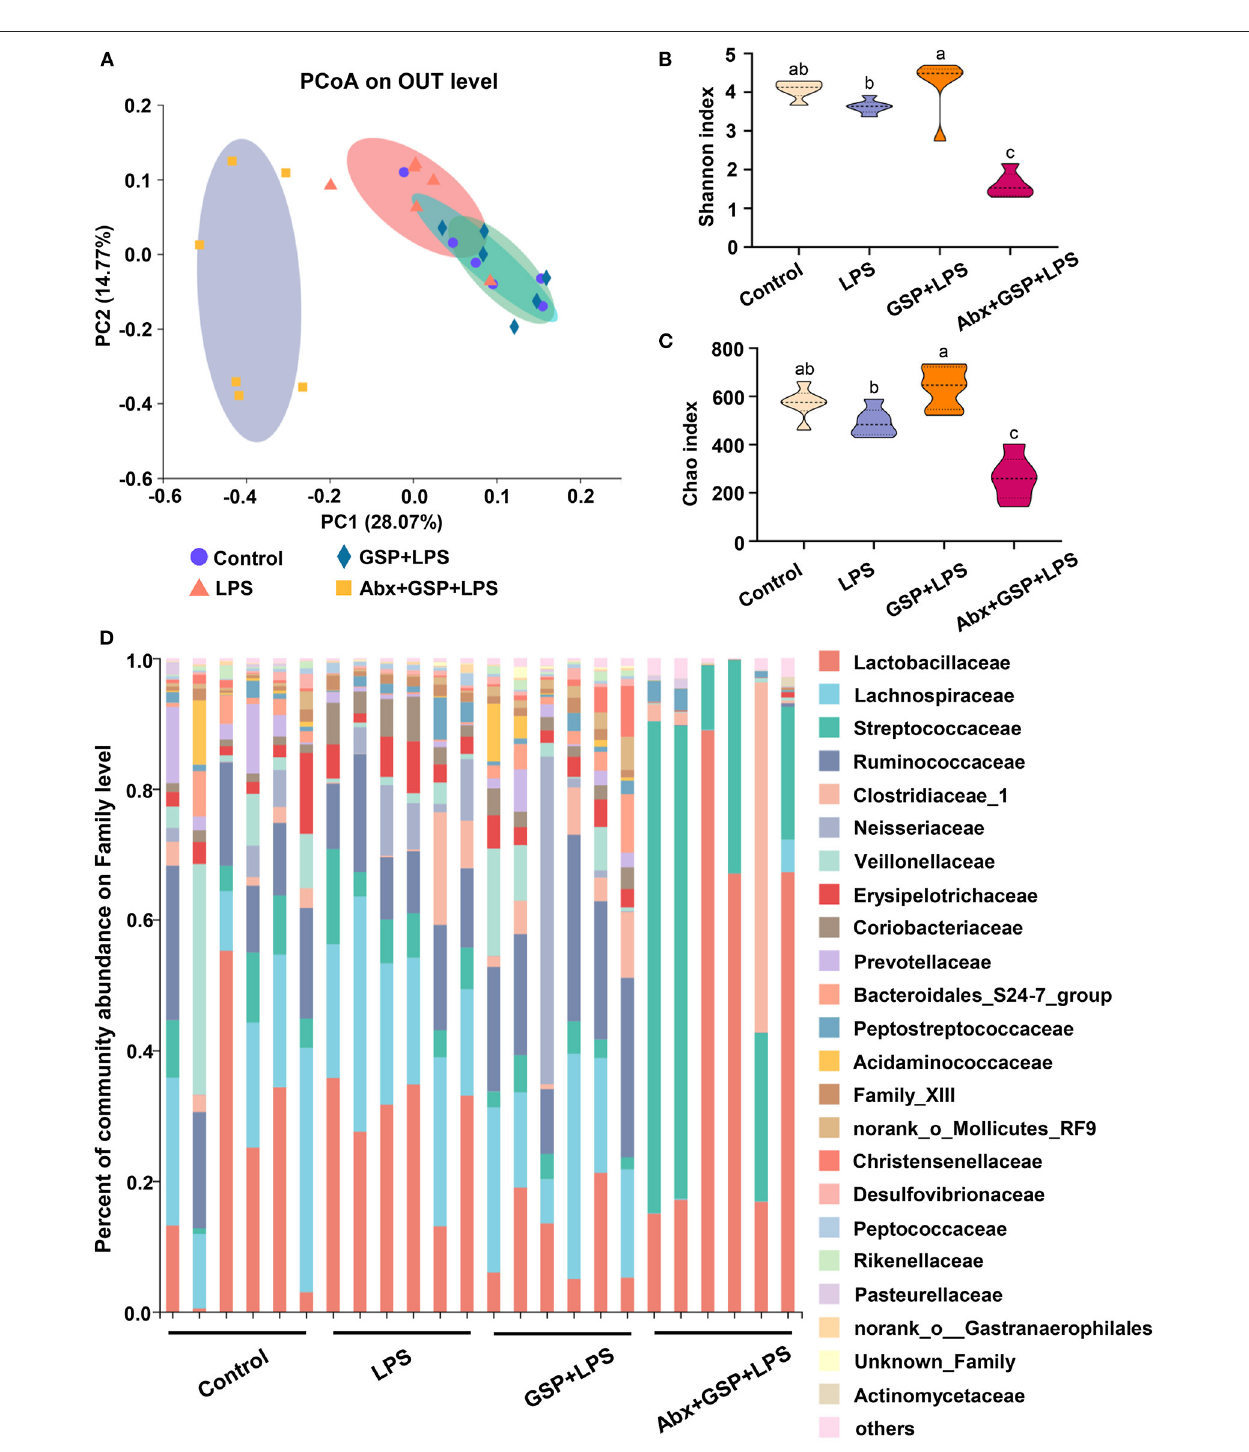
FIGURE 2 | The analyze of bacterial β -diversity and microbial structures in C57BL/6 mice with different treatments in Experiment 1. (A) Principal coordinates analysis (PCoA) diagram of the cecum bacterial communities based on Bray-Curtis distance calculated from OTUs abundance matrix. (B,C) The indexes of Shannon and Chao. (D) The relative abundance of caecum bacteria at the family level. Control, control group that oral gavaged with physiological saline before i.p. PBS injection; LPS, a LPS injection group that oral gavaged with physiological saline before i.p. LPS injection; GSP + LPS, a GSP administration group that oral gavaged with 250 mg/kg GSP before i.p. LPS injection; Abx + GSP + LPS, an antibiotic group that given a mixture of antibiotics in drinking water before the Experiment 1, and then coupled with GSP before i.p. LPS injection. Data are presented by the mean ± SEMs ( n = 6). Bars with no letter in common are significantly different, p ≤ 0.05.